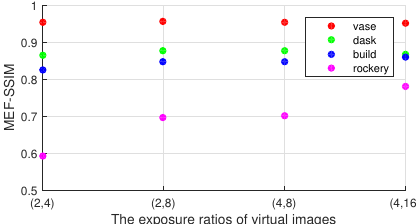
Figure 3. The MEF-SSIMs of enhanced images under different virtual images of different exposure ratios.